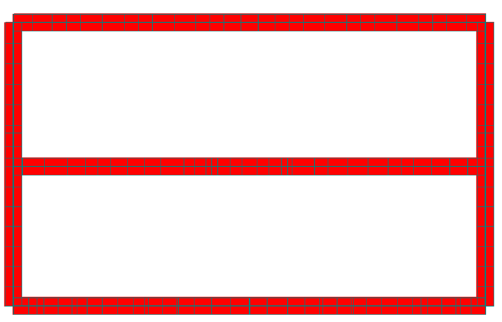
Figure 18. Outcome of verification on the existing foundations (all red elements are not verified).